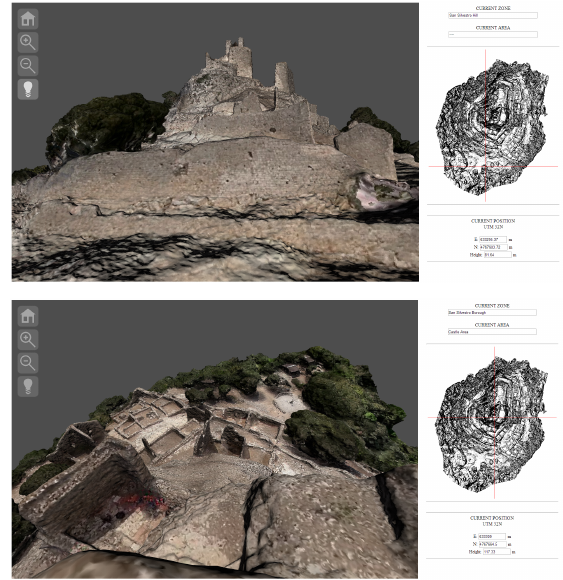
Figure 8: Two snapshot of first person navigation of San Silvestro model. Top: on top of the tower. Bottom: from the industrial area outside the